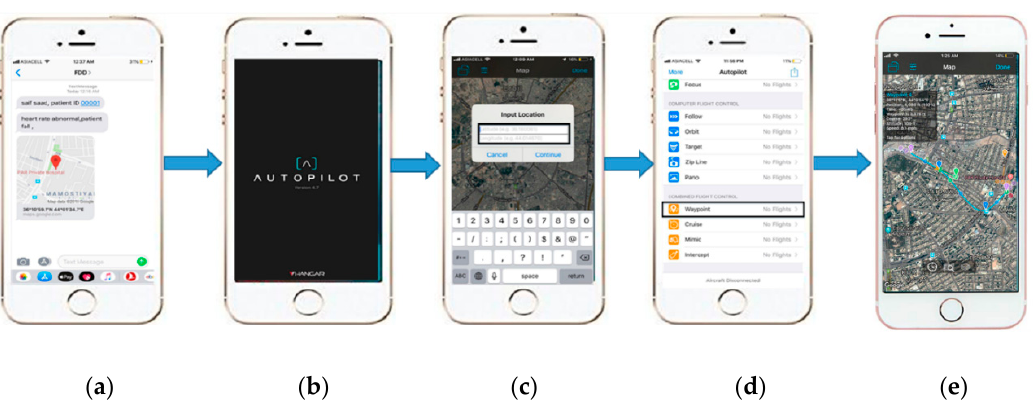
Figure 8. Smartphone of caregivers with ( a ) Patient information ( b ) Autopilot window, ( c ) Location information, ( d ) Waypoint mode, and ( e ) Flight path planning.